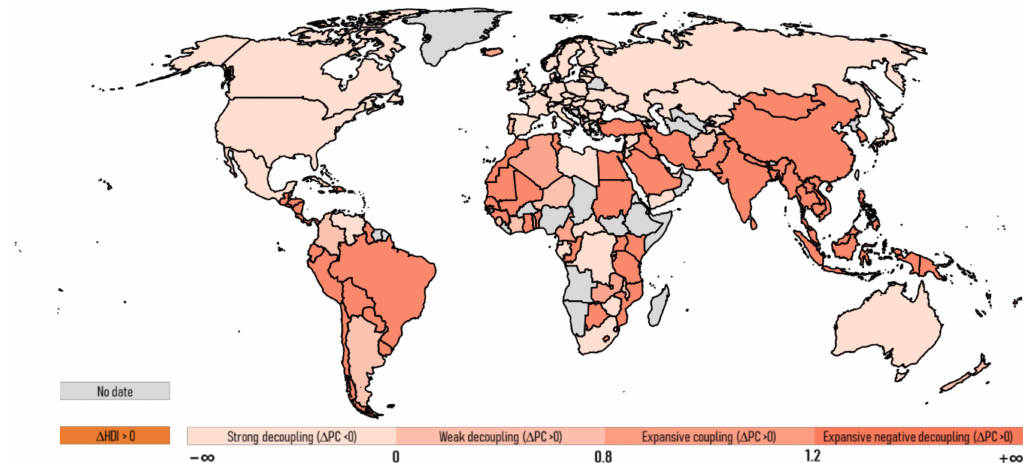
Figure 2. Decoupling between carbon emissions per capita and HDI, 1990–2019. Source: Authors’ own construction using